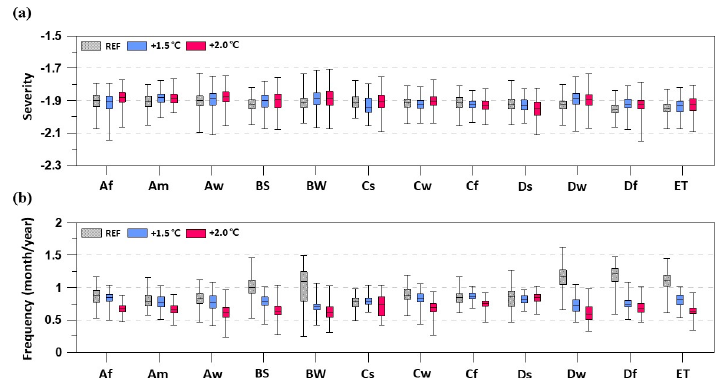
Figure 7. Box-whisker plot for spatial variability of mean ( a ) value of severe drought; ( b ) frequency of severe drought (unit: times/year) based on the severe drought events (e.g., SPI3 <-1.5) during the REF period and 1.5 °C (2.0 °C) of global warming period in the Asian monsoon region. The gray, blue, and red colors indicate the MME-based results of REF period and 1.5 and 2.0 °C global warming period, respectively.